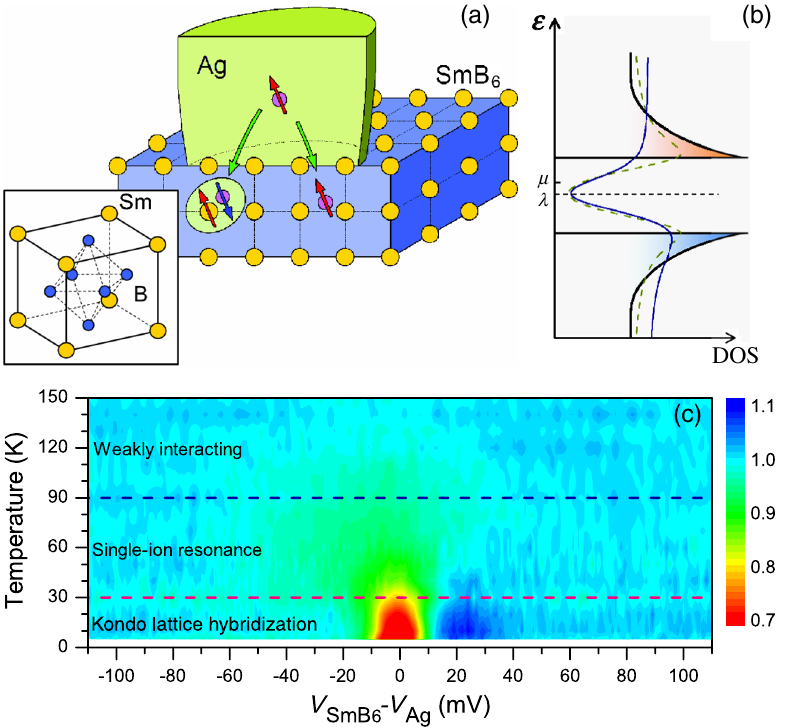
FIG. 1. (a) A schematic view for a Ag - Sm junction. A Fano-like conductance spectrum is expected due to the interference of the 6 two electron paths, as indicated by the two green arrows: One leads directly into the itinerant electron states (right side), and thus should reflect the DOS. The other leads indirectly into the electron sea through a spin-singlet Kondo state (left side). Inset: The crystal single crystal. The Sm ions form a simple cubic structure. (b) A schematic view of the DOS for the ground state structure of the SmB 6 . In point-contact-spectroscopy measurement, quasiparticle broadening should be taken into account, as indicated by the green of SmB 6 dashed line. The blue solid curve is the expected spectrum with Fano resonance. (cid:1) is the chemical potential while (cid:2) is the renormalized f level. (c) The contour map of the normalized conductance in the bias voltage-temperature ( V - T ) plane. All conductance data are normalized by the spectrum conductance obtained at 150 K. As indicated by the color legend, red and blue colors represent values below 0.7 and above 1.1, respectively. At temperatures above about 90 K , the conductance spectroscopy of the junction is highly symmetric, with negligible temperature dependence due to the weak interaction between electrons and local moments. From 90 K to 30 K, the zero-bias conductance is gradually suppressed, while an asymmetric conductance line shape develops. In this temperature range, the conductance spectrum can be described by the single-ion resonance model. Below about 30 K , the conductance spectra are clearly asymmetric with a dip at zero bias and a peak at 20 mV. As discussed in the main text, this strongly asymmetric conductance line shape provides direct evidence for the inter-ion correlations in the Kondo lattice